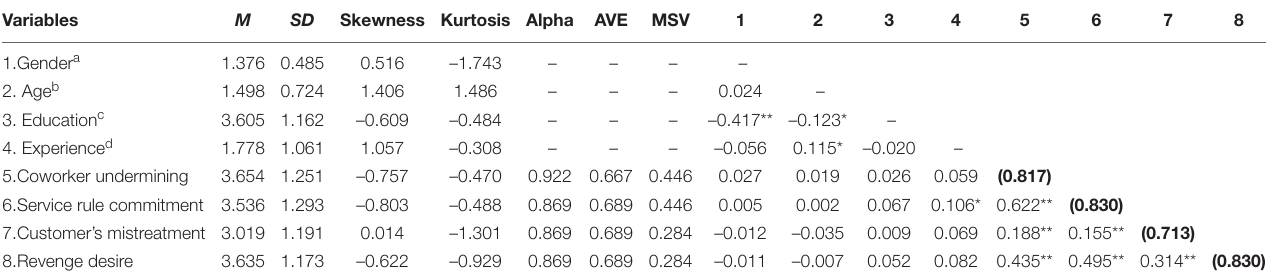
TABLE 1 | Inter-correlations, descriptive statistics, and estimated reliabilities among the latent variables. Variables M SD Skewness Kurtosis Alpha AVE